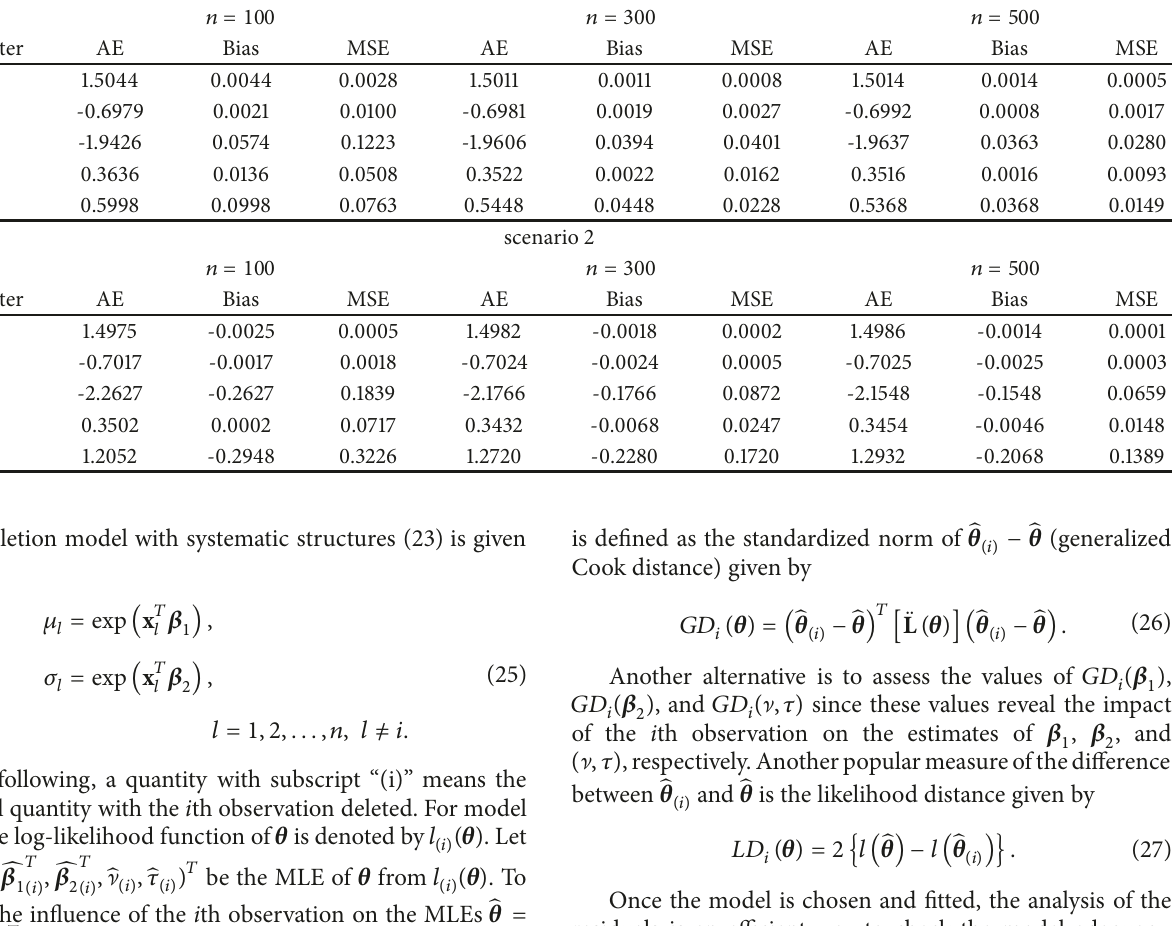
Table 2: AEs, biases, and MSEs for the OLLGIG regression model under scenarios 1 and 2. scenario